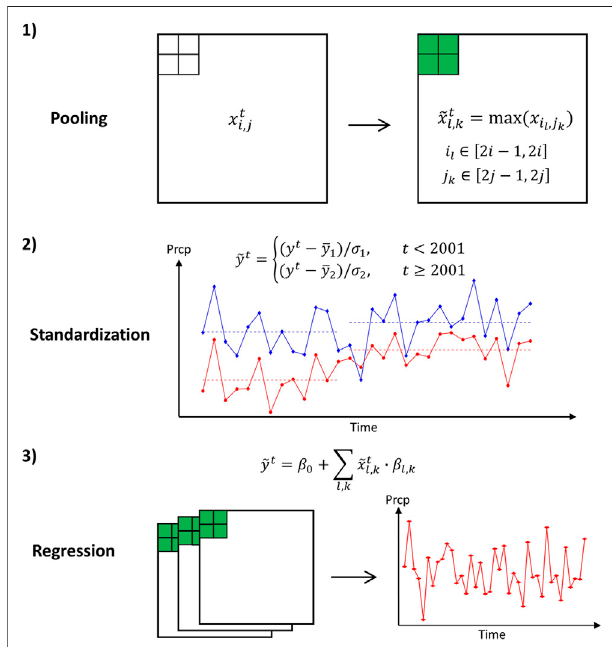
FIGURE2| Aschematic oftheproposedthe regressionmodel coupling max pooling and elastic net.